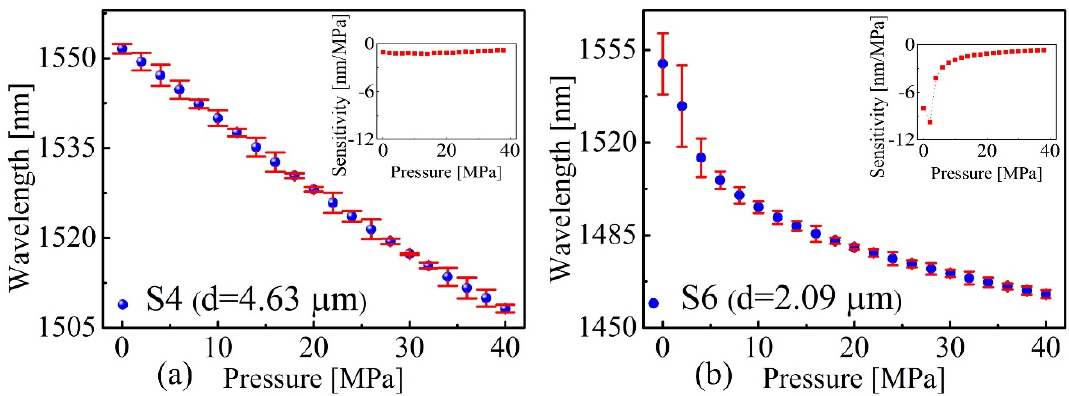
Figure 5. Wavelength of the tracked dip versus pressure for ( a ) S4 and ( b ) S6, respectively. The insets show the corresponding pressure sensitivities of S4 and S6 as functions of pressure.